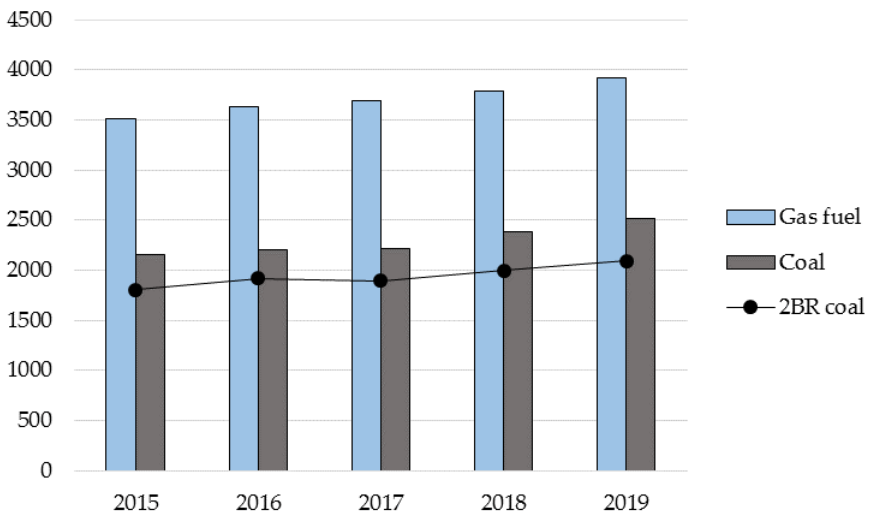
Figure 6. Prices for the main fuels for thermal power in Russian rubles per ton of fuel equivalent. Source: Informational and Analytical Report Heat Power and District Heating in Russia.